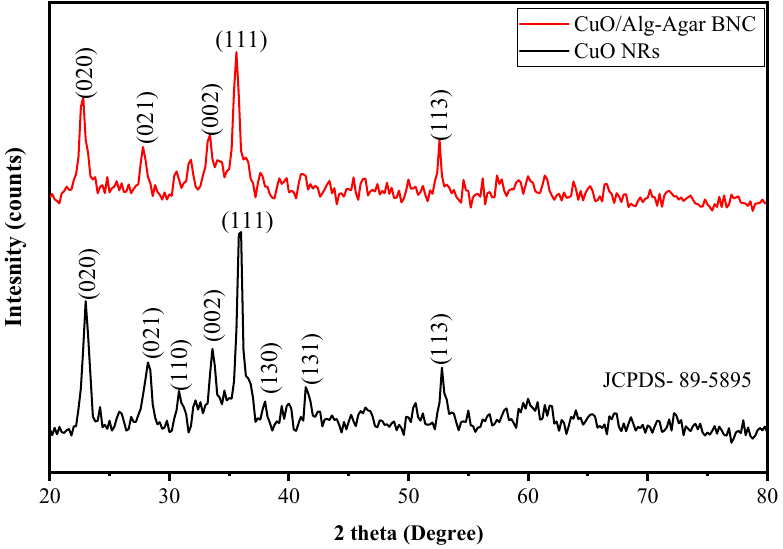
Figure 3. XRD spectra of CuO NRs (black line) and CuO/Alg-Agar BNC (red line). The information about crystalline size and %crystallinity can be calculated using Equations (4) and (5) [42].